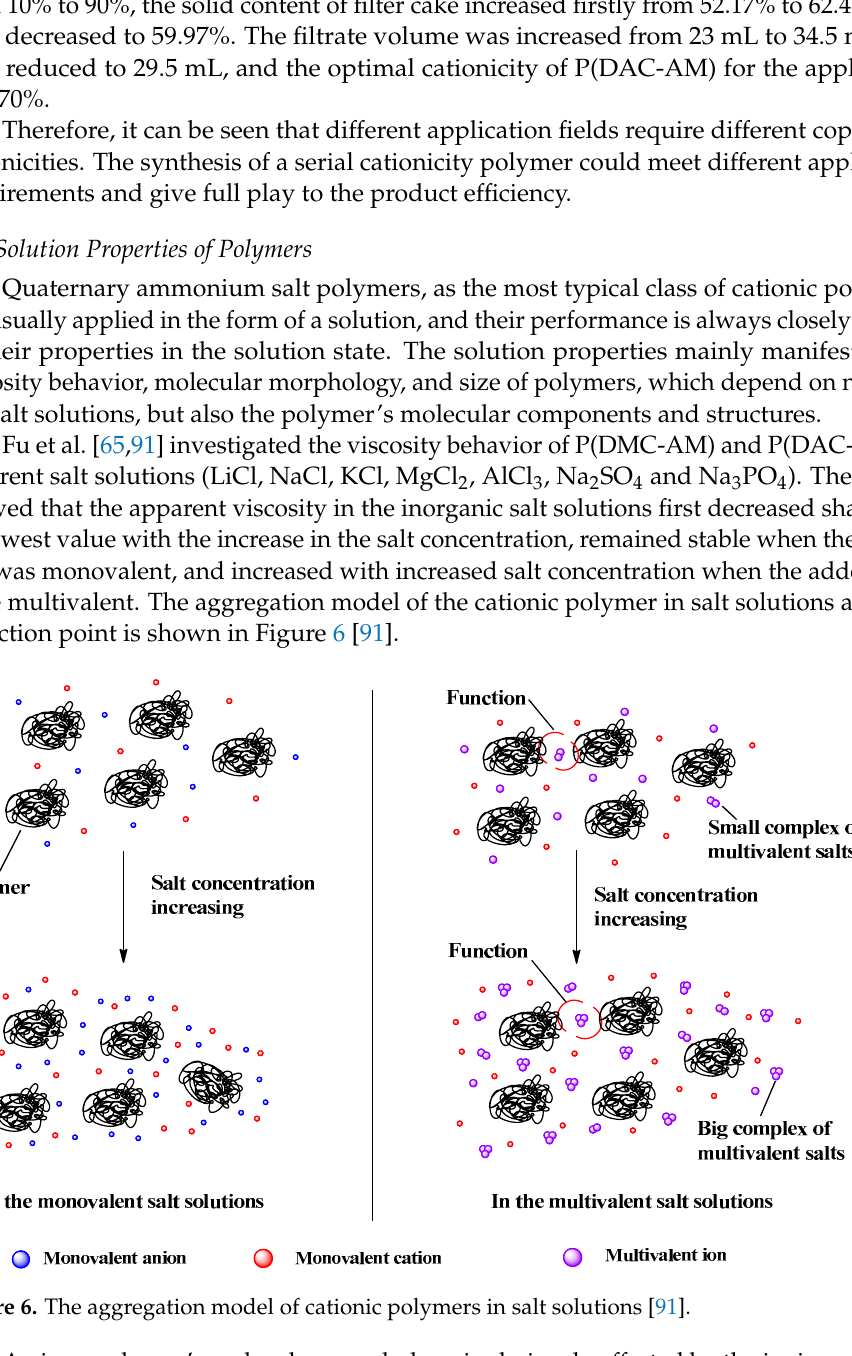
Table 2. The values of K and α in the Mark ‐ Houwink equation [13,95,97]. Polymer K